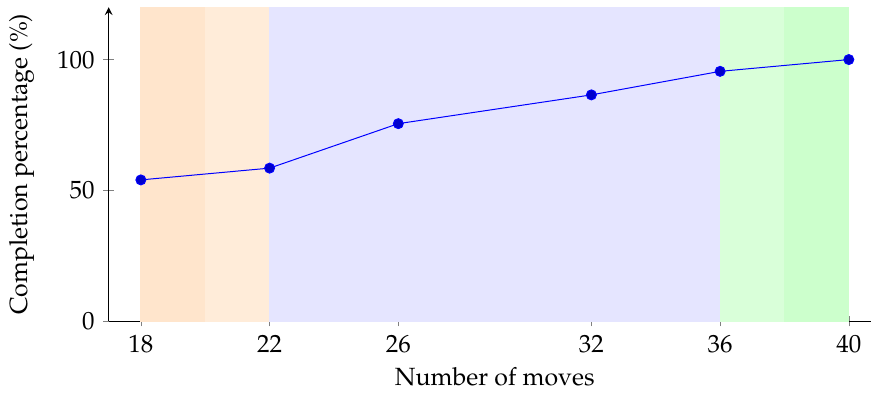
Figure 8. The completion percentage of PPNS in different stages of Othello. The left-most area colored in orange represents the opening stage of Othello, the middle area (blue) represents the middle game of Othello, and the right-most green area represents the end game of